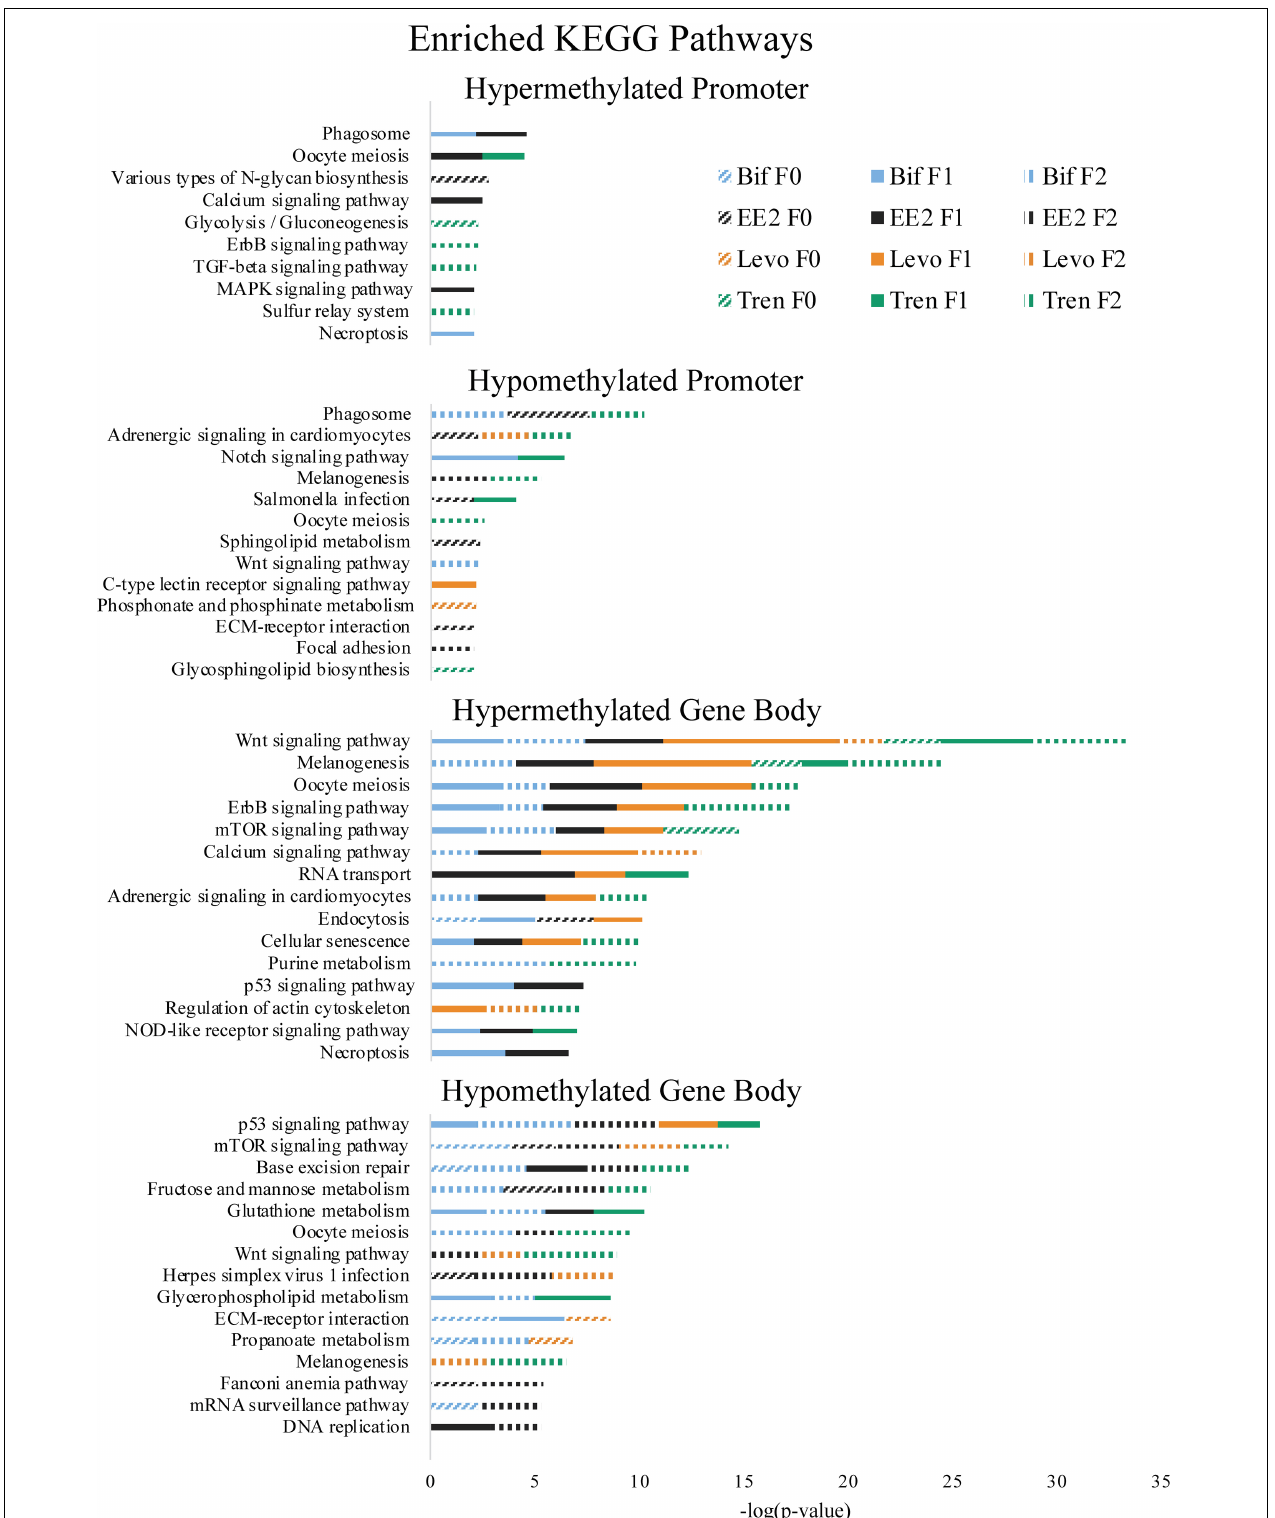
FIGURE 5 | Enriched Kyoto Encyclopedia of Genes and Genomes (KEGG) pathways by directional methylation change relative to the control (hyper, hypo), gene region (promoter, gene body), treatment (Bif, EE2, Levo, Tren), and generation (F0, F1, F2) showing level of significance based on Fishers exact test p -values.